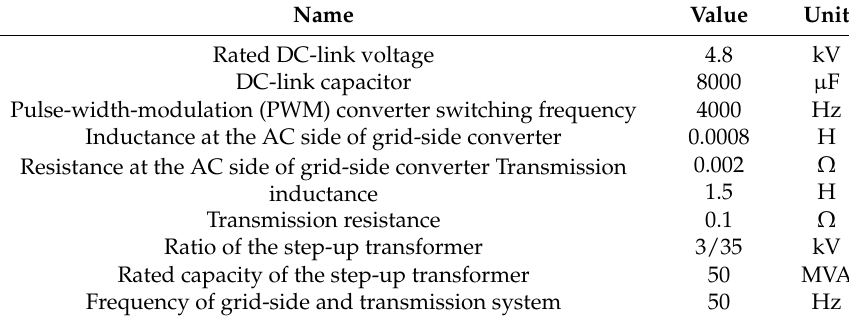
Table 3. Parameters definition of the converter and transmission system in